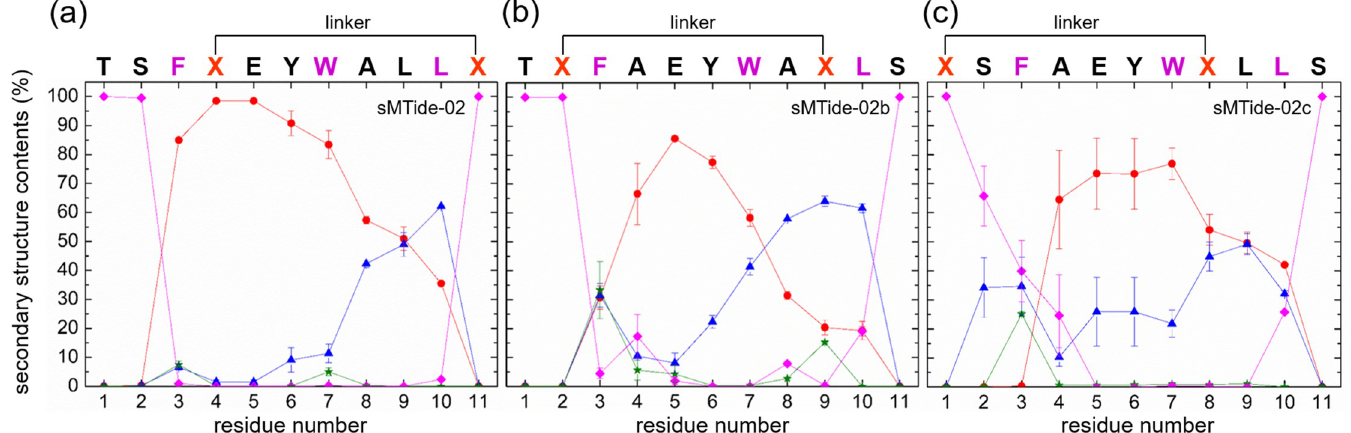
Fig 2. Average secondary structure contents of the free stapled p53 peptides. (a–c) Average secondary structure contents for the free sMTide-02 (a), sMTide-02b (b) and sMTide-02c (c) (red circles, helix; blue triangles, turn; green stars, bend, and magenta diamonds, coil).